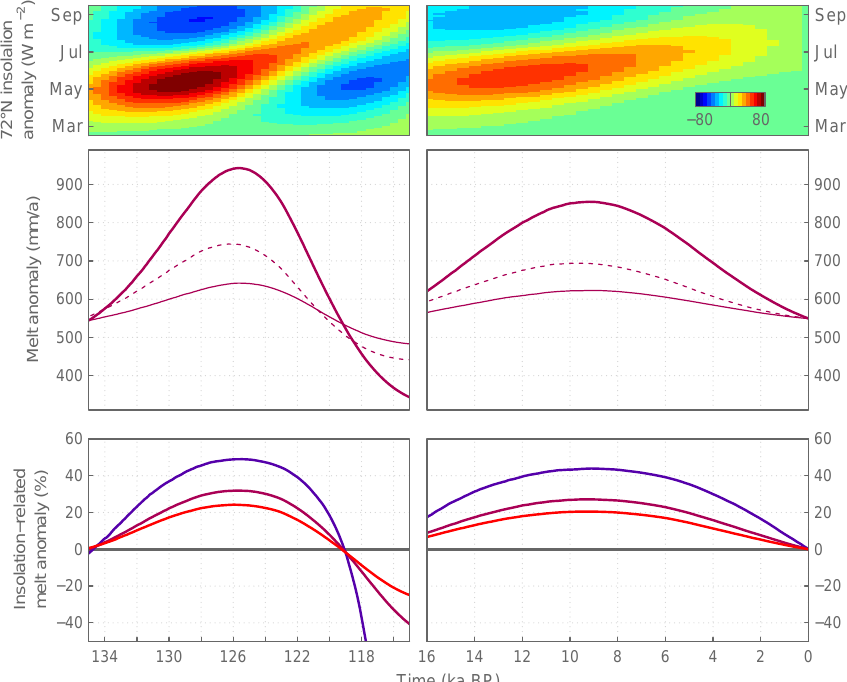
Figure 1. Melt anomalies relative to the present day for the Eemian (left) and the Holocene (right). Top: representative insolation anomaly at 72 ◦ N for summer months (March–September). Middle: melt anomalies, given a constant JJA temperature anomaly of 3 ◦ C calculated from the full model (thick line), the reduced model (thin line) and the reduced model using surface conditions from the full model (dashed line). Bottom: percentage of the melt anomaly due to changes in insolation for constant summer temperature anomalies of 1, 3 and 5 ◦ C (blue, purple and red,